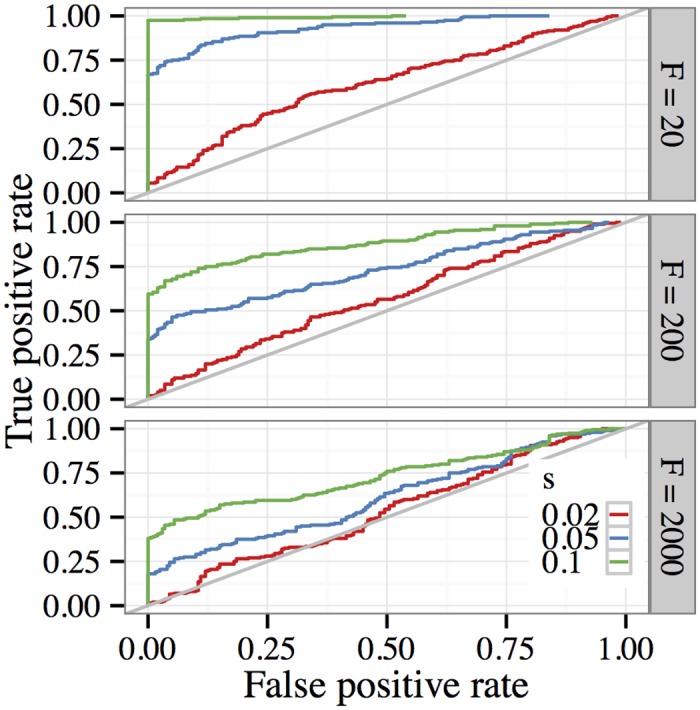
Receiver operating characteristics (ROC) when testing for selection in a region under the default parameter setting.Each ROC curve was estimated using 200 simulations. For each selection regime, the curve was calculated by comparing the distribution of the maximum likelihood-ratio over all segregating sites in a region of length 100 kb with the distribution of the same statistic under neutrality. As the plots show, stronger selection is easier to detect than weaker selection, and increased haplotypic diversity makes it more difficult to confidently reject the null hypothesis of neutrality.